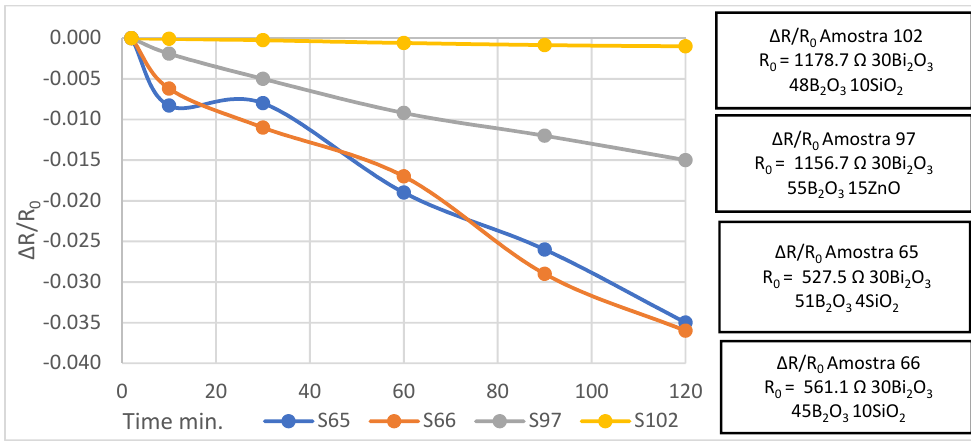
Figure 3. Results of resistance evolution after strain load removal.